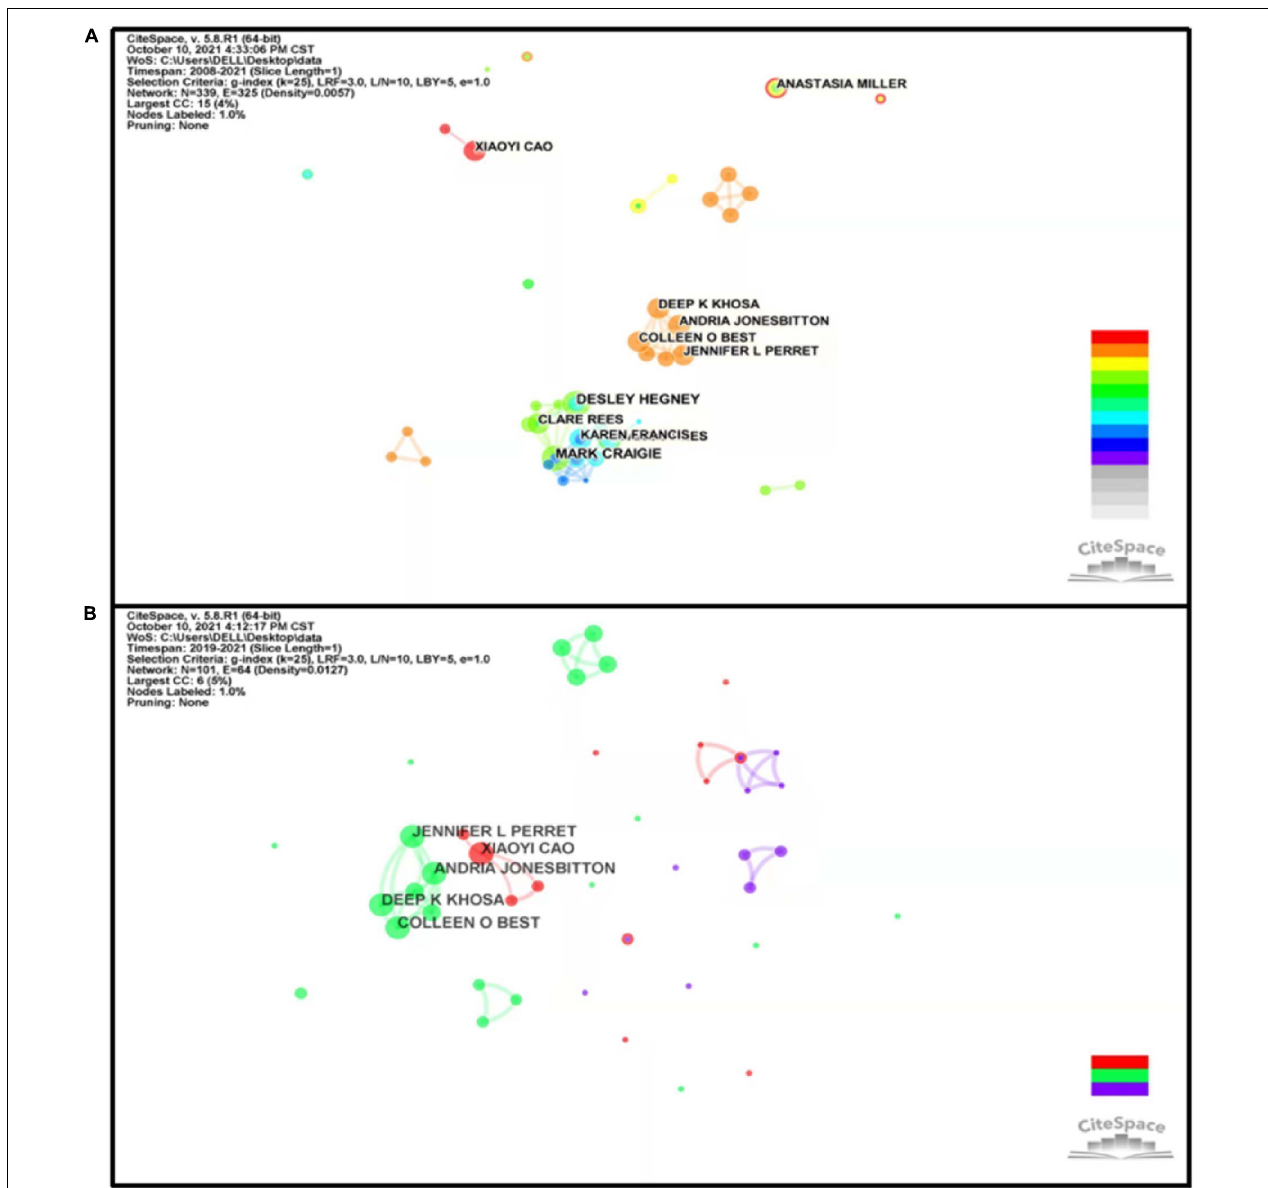
FIGURE 5 | The network of co-authorship in the field of CF and PR during 2008–2021 (A) and the COVID-19 pandemic (B) . The individual circle indicates one author, and the size of the circle was weighted by the number of articles published by authors. The individual link between two circles indicates collaboration between two authors on the same article, and its thickness was weighted by the frequency of collaborations. The purple rims of circles indicate high betweenness centralities.